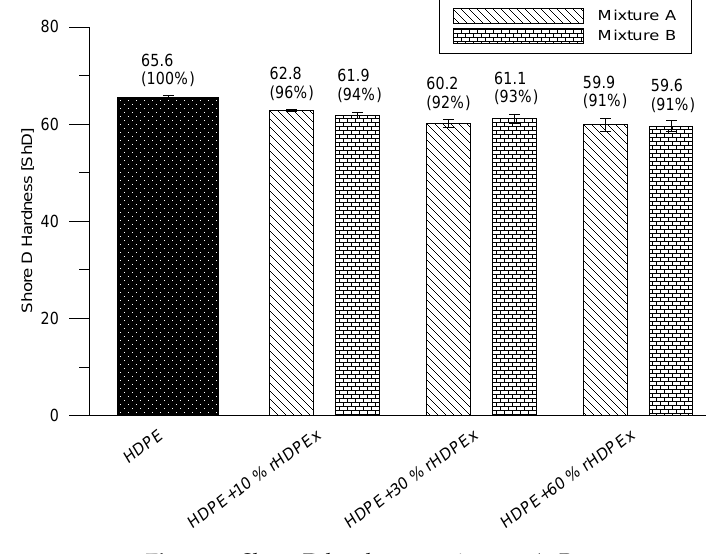
Figure 6. Shore D hardness—mixtures A, B.